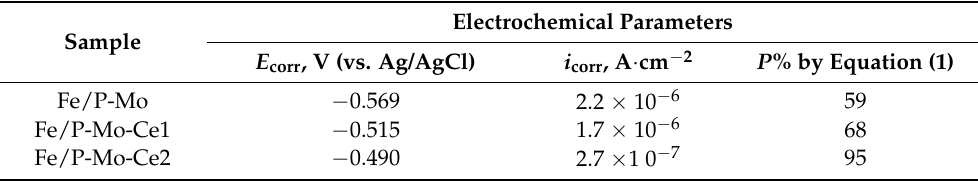
Figure 6. Potentiodynamic polarization curves of the conversion coating electrodes: 1—Fe/P-Mo; 2—Fe/P-Mo-Ce1; 3—Fe/Mo-Ce2 in a 0.5 M NaCl solution at 25 °C; 0.5 mV s − 1 . Table 2. The electrochemical parameters and protection efficiency ( P %) of conversion coatings determined in 0.5 M NaCl